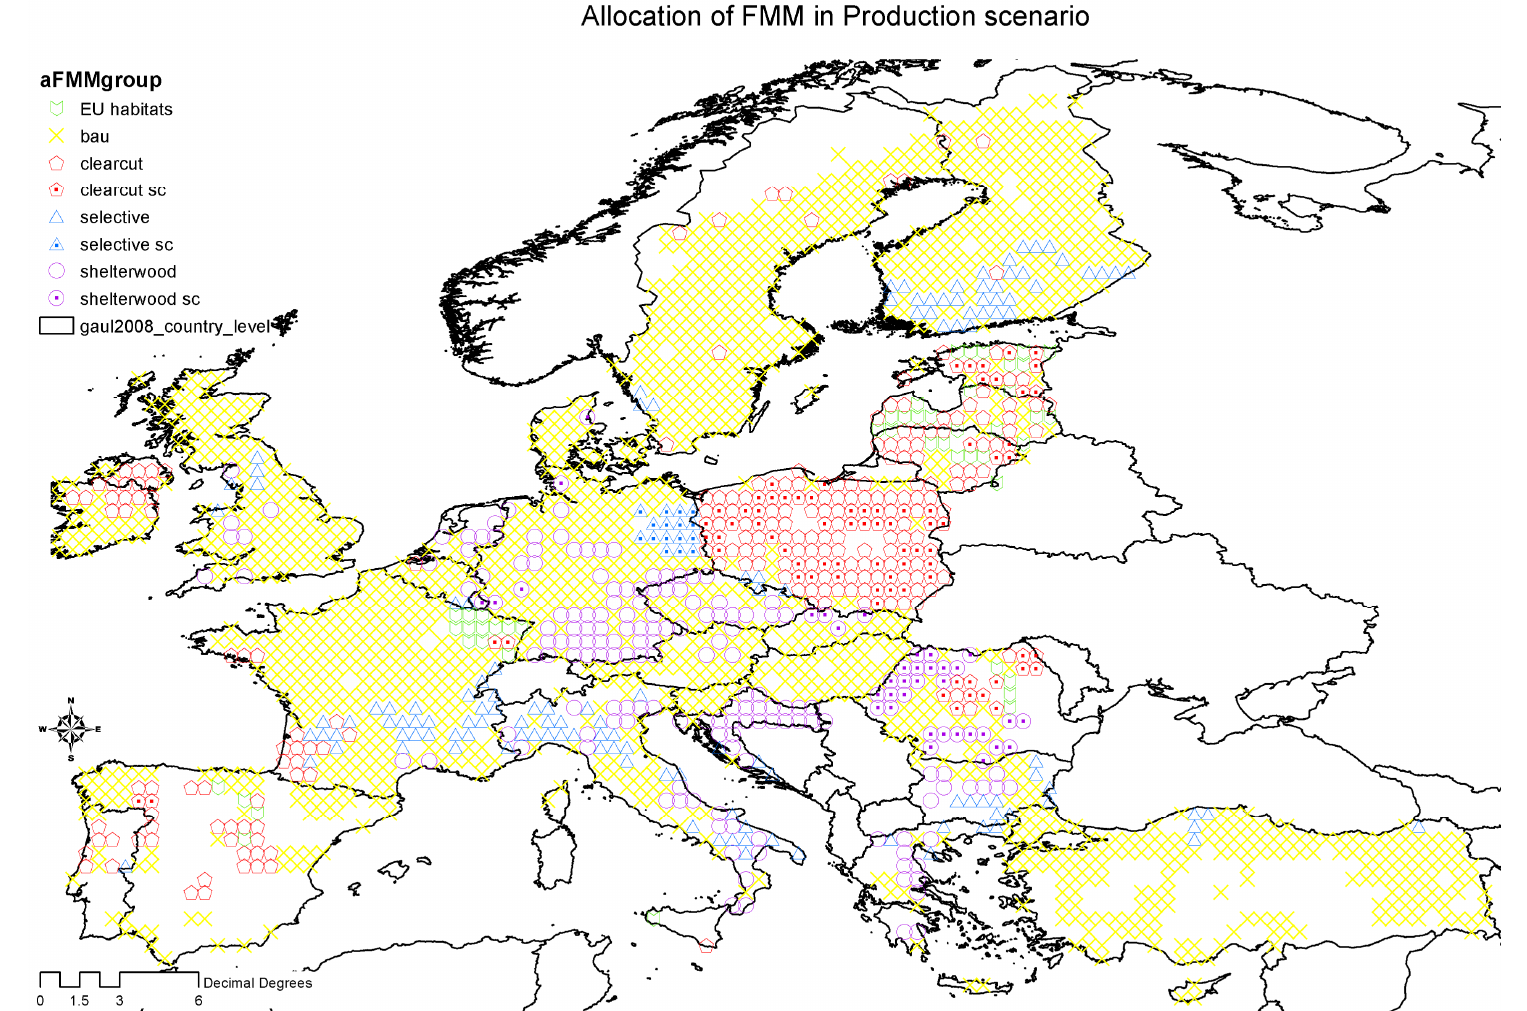
Figure 2. Allocation of the forest management models in the production